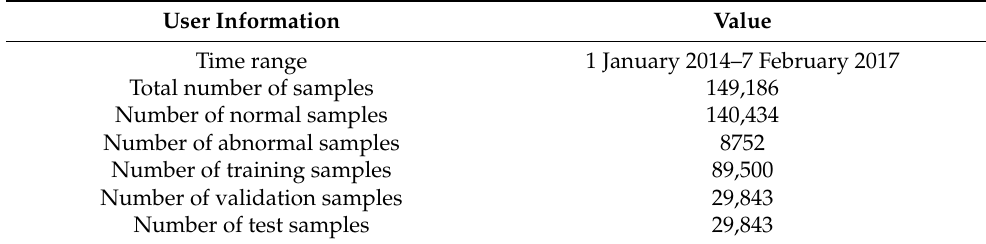
Table 1. Basic information of the